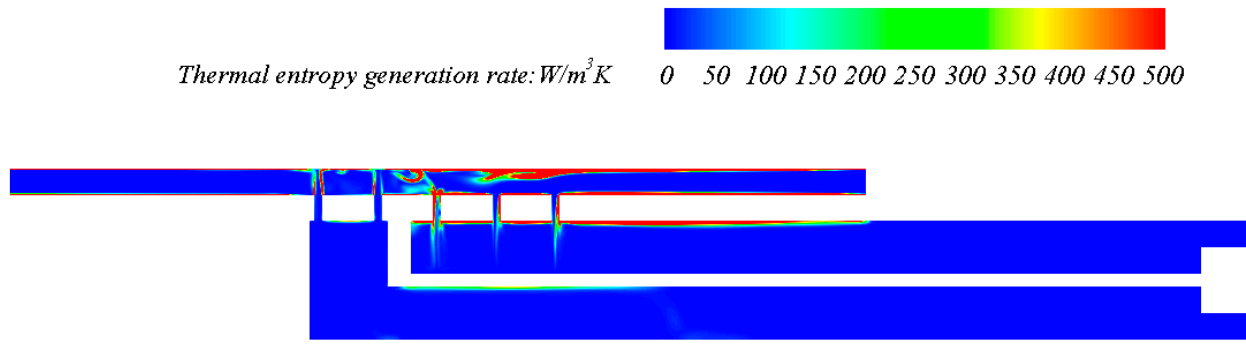
Figure 16. Thermal entropy generation rate in the fluid domain ( x = 28.5 mm, 0.75 T of DSJ on).